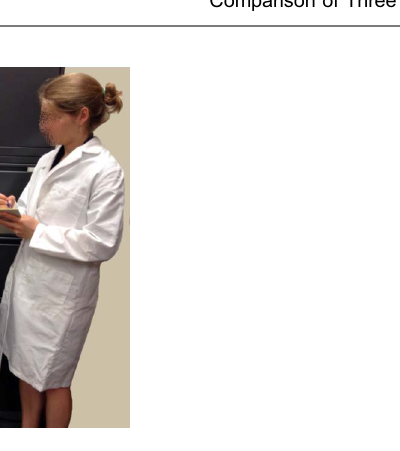
Fig. 1. Socially Evaluative Cold Pressor Test (SECPT). Image represents the SECPT, in which participants immerse their arm, up to the elbow, in ice water (4 ˚ C) for up to 3 minutes, in front of a videocamera and